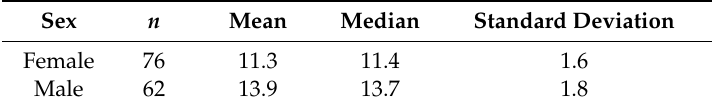
Table 2. Mean and standard deviation of hemoglobin by